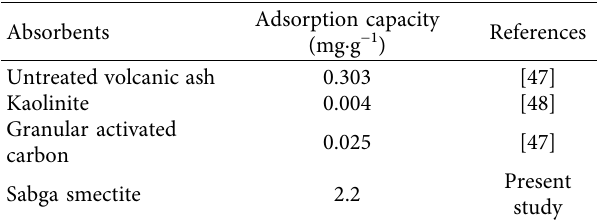
Table 11: Comparison of adsorption capacity of manganese (II)